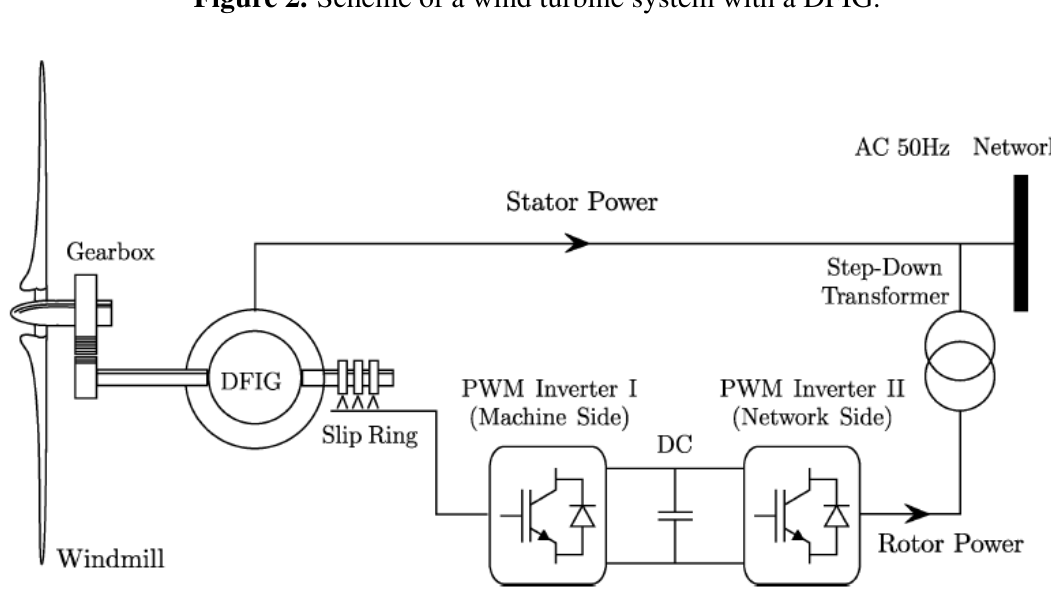
Figure 2. Scheme of a wind turbine system with a